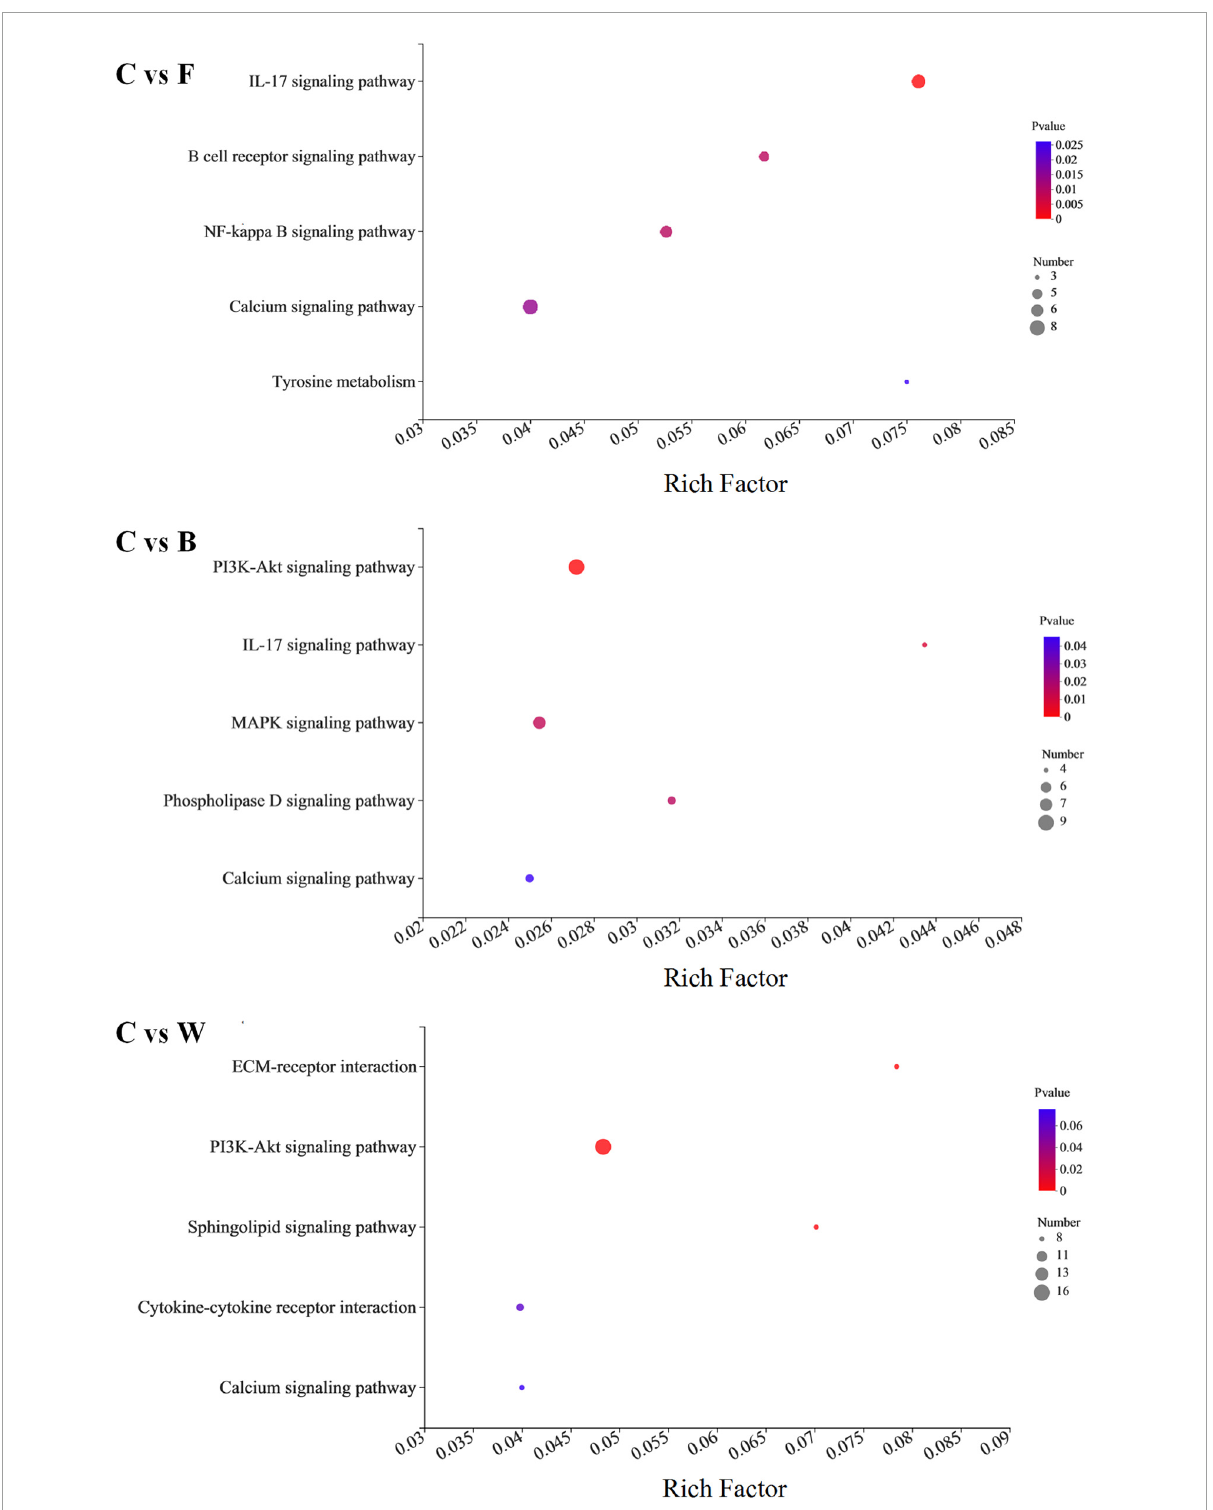
FIGURE6 Enrichment analysis based on the Kyoto Encyclopedia of Genes and Genomes (KEGG) database of the differentially expressed genes (DEGs) identified between the control (group C) and each of the three experimental groups of Landes geese (i.e., groups F, B, and W) on day 90. The larger Rich factor value indicates the greater enrichment. The size of the dots indicates proportionally the number of genes enriched in the pathway; the color of the dots corresponds to the P -value ranges. Group C, control group; Group B, added with 4% BSG in the overfeeding stage (days 61–90); Group F, added with 4% BSG in the rearing stage (days 5–60); Group W, added with 4% BSG in the all stage (days